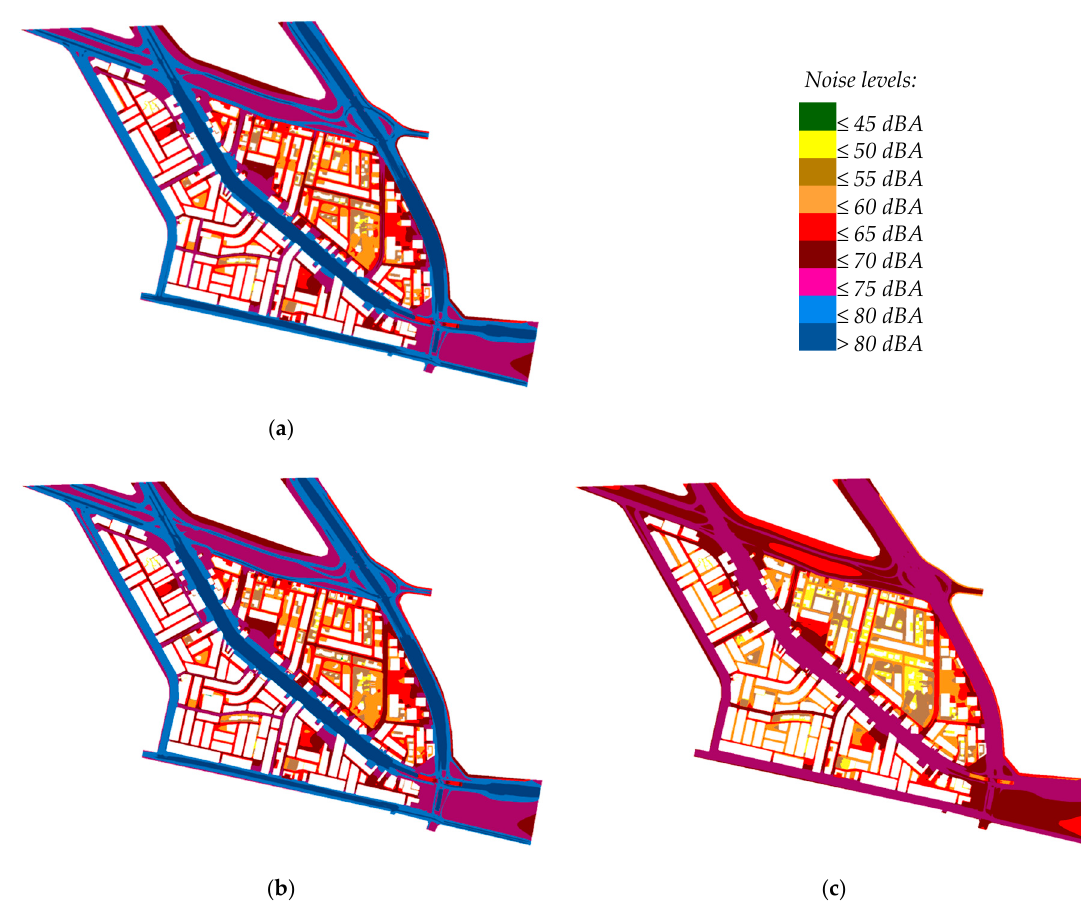
Figure 5. Predicted noise levels due to traffic activities in Al-Fayha District. ( a ) Daytime level (LAeq,D); ( b ) Evening time level (LAeq,E); ( c ) Nighttime level (LAeq,N).